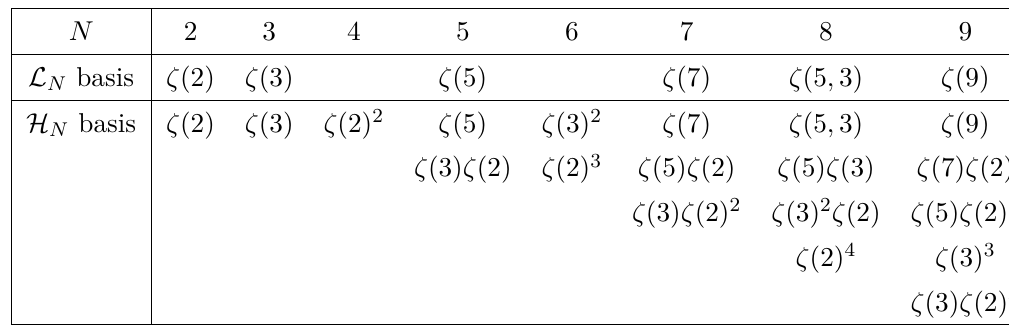
Table 1 . Possible basis for H and L .